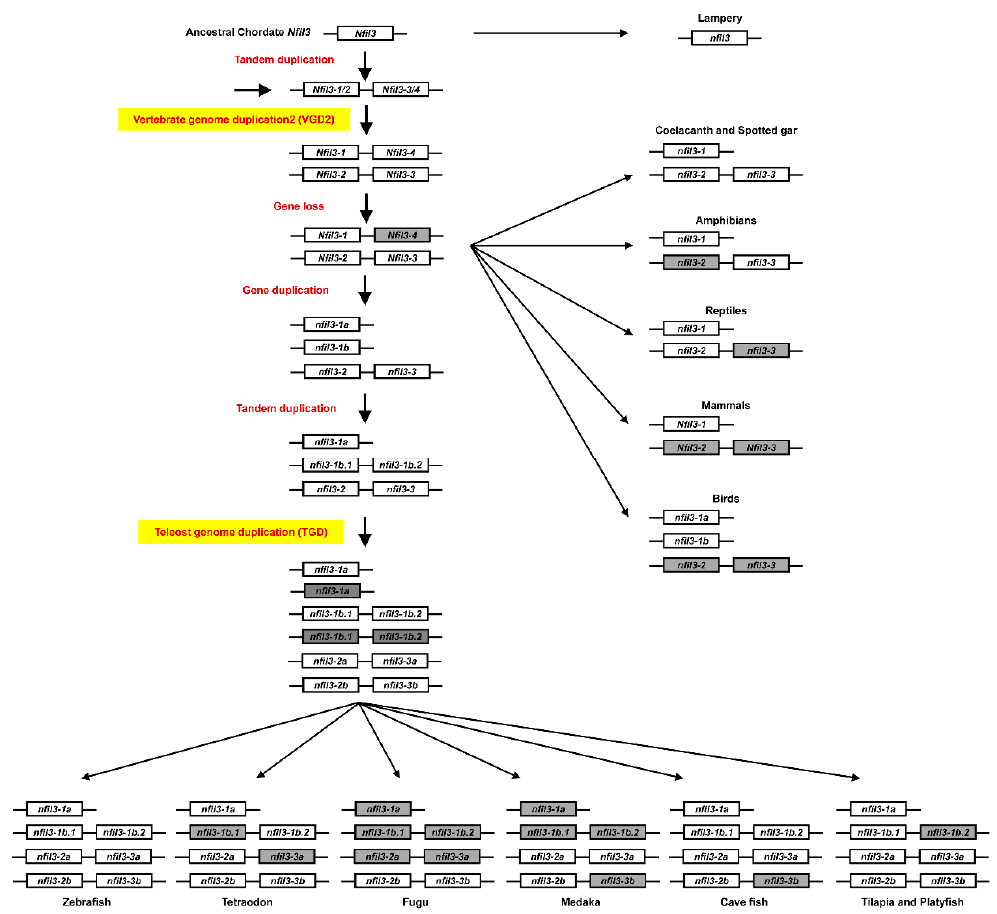
Figure 6. A hypothetical model for the evolution of nfil3 genes in vertebrates. The teleost fish and tetrapod nfil3 had a common ancestor. The ancestral nfil3 gave rise to nfil3-1 / 2 and nfil3-3 / 4 by tandem duplication. During the second round of vertebrate genome duplication, the cluster was duplicated to nfil3-1, nfil3-2, nfil3-3 , and nfil3-4 genes, with the quick loss of nfil3-4 . The nfil3-1 is conserved in all vertebrates, with the exception of losses in a few teleost fish. The nfil3-1b.1 and nfil3-1b.2 linkage has been preserved only in teleost fish. The nfil3-2 and nfil3-3 linkage was conserved in the teleost fish and tetrapod lineages. The teleost-specific genome duplication produced the nfil3-2a / nfil3-2b duplicate, which was observed in zebrafish, medaka, tetrodon, tilapia, platyfish, and cave fish; and the nfil3-3a / nfil3-3b duplicate, which was observed in zebrafish, tilapia, and platyfish. However, amphibians retained only nfil3-3 and reptiles retained only nfil3-2 . Then, Nfil3-2 and Nfil3-3 were completely lost in the lineages of mammals and birds during evolution. The grey box means gene loss.